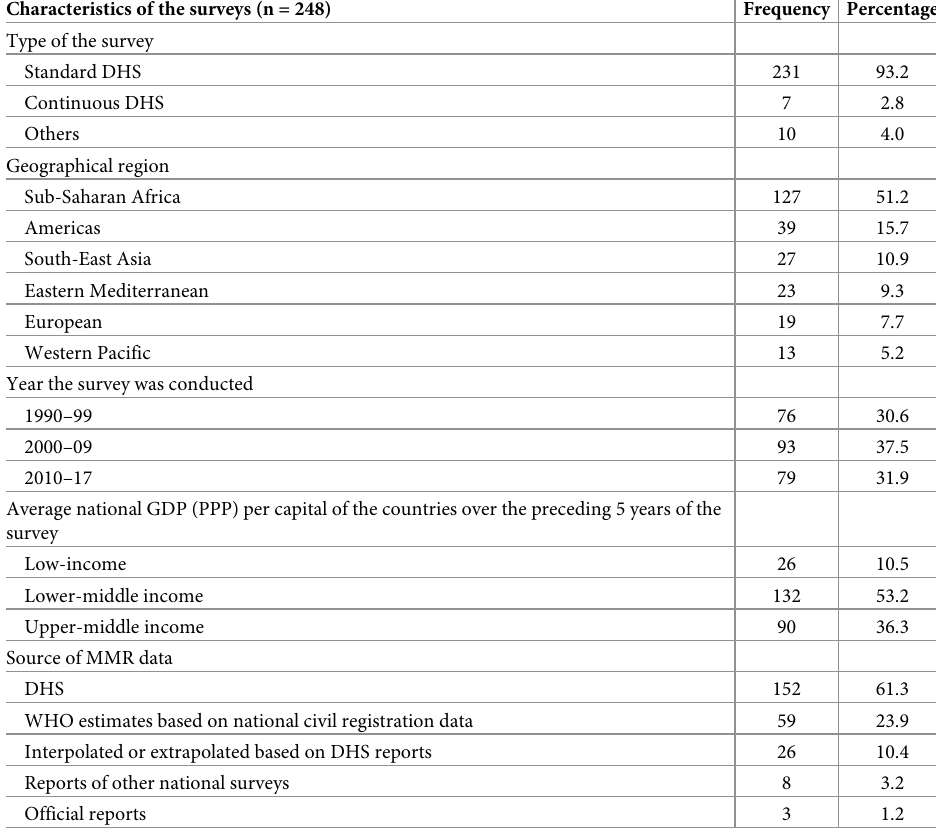
Table 1. Summary of the surveys included in the development of the model, 1990–2017. Characteristics of the surveys (n =